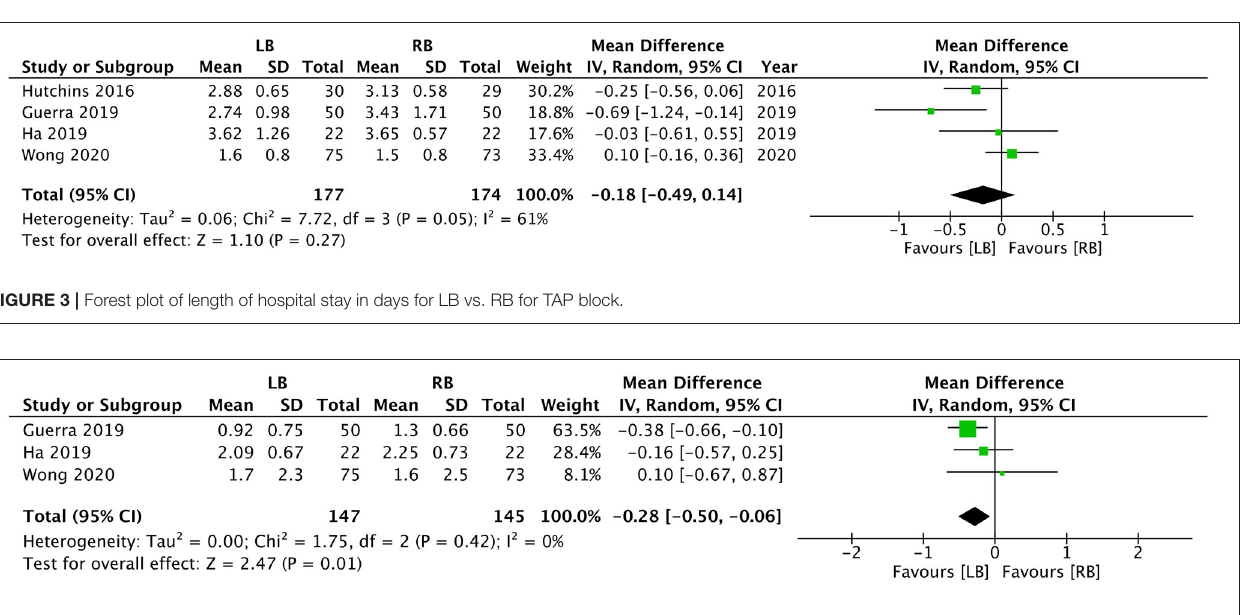
nonsignificant results. Second, accurate placement of the block is essential for optimal pain relief (30). In the trial of Nedeljkovic et al. (30), around 6% of patients received incorrect TAP blocks